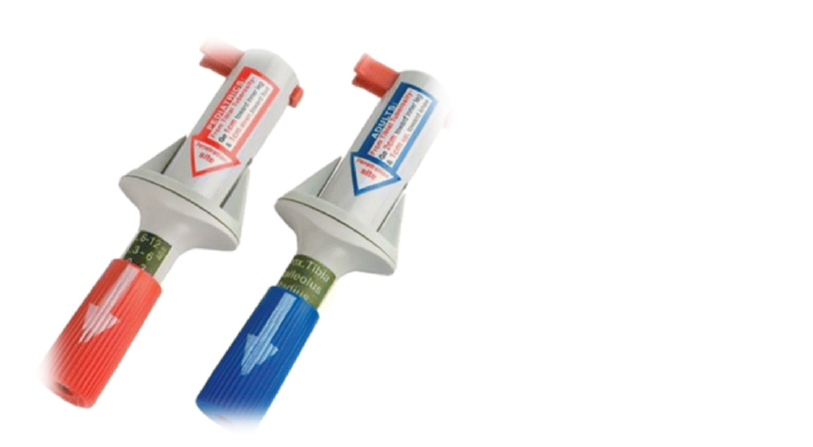
Figure 3. BIG intraosseous device. Source: Journal of Anales de Pediatría , 2015 (13).